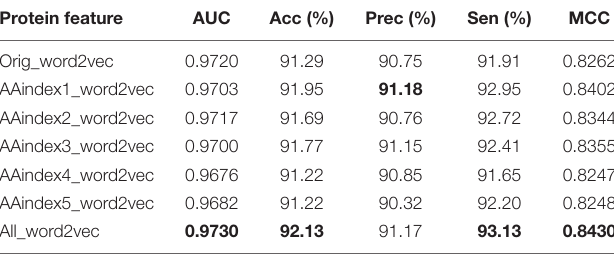
TABLE 3 | Performance of different protein representations on the ion channel dataset. Protein feature